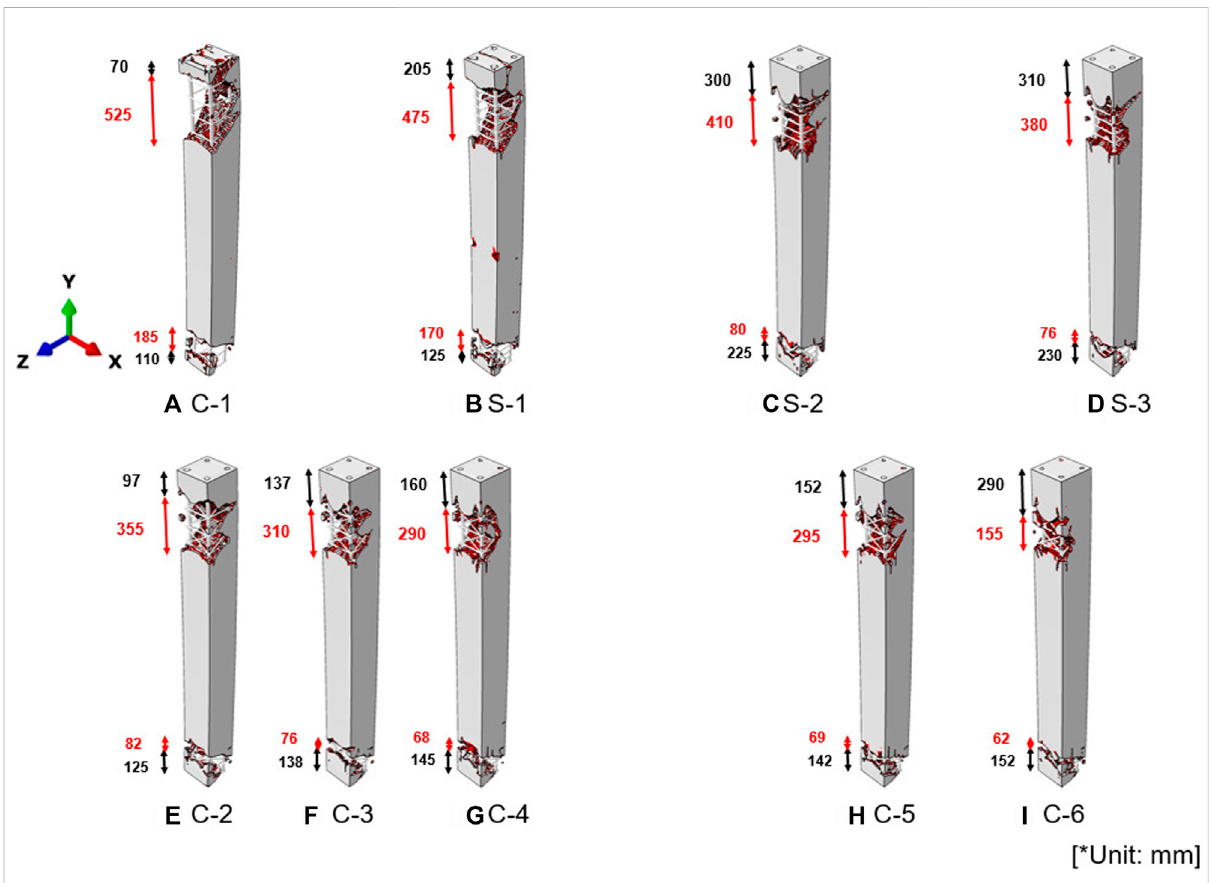
FIGURE 7 Pro fi le of concrete crushing in the